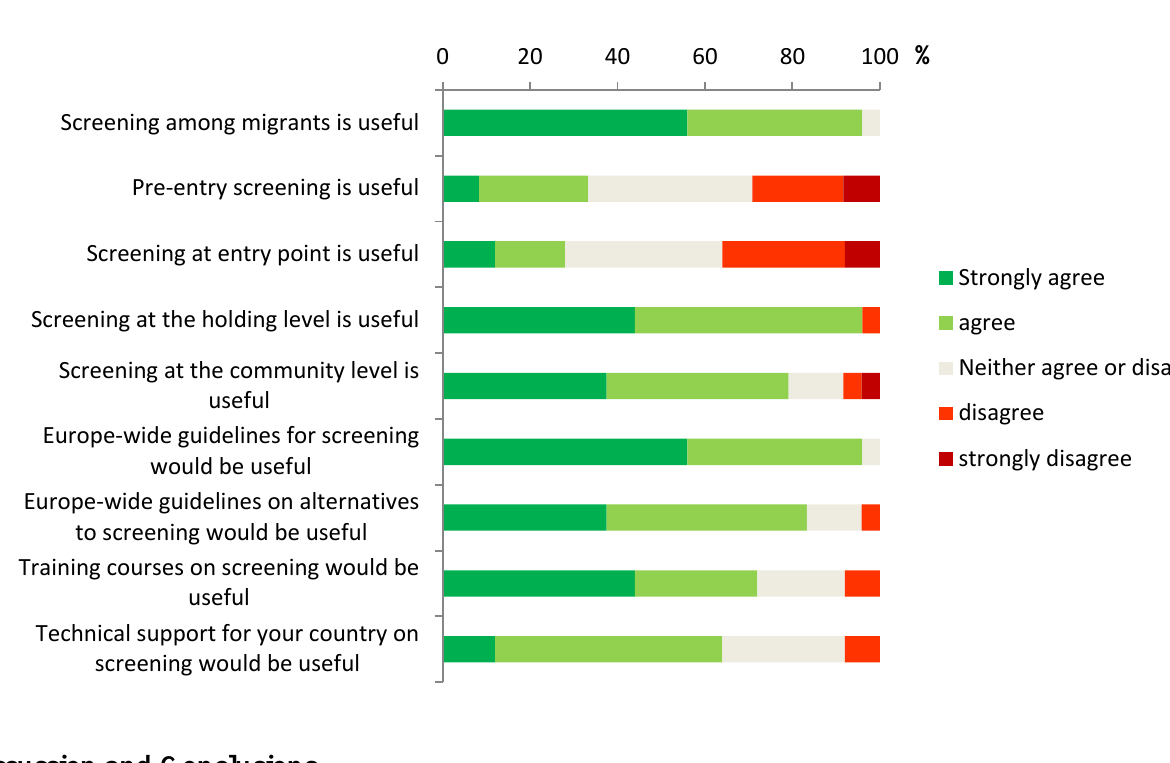
Figure 3. Expert opinions on the usefulness of screening and of potential actions taken on international level ( n =